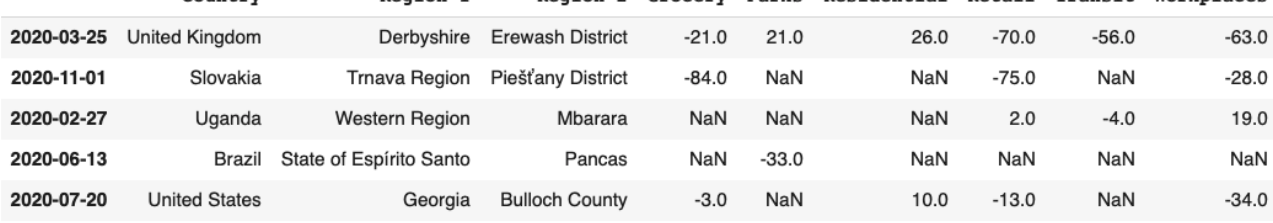
Figure 1. Google Community Mobility Reports database. Source of basic data: Covid-19 Community Mobility Reports,